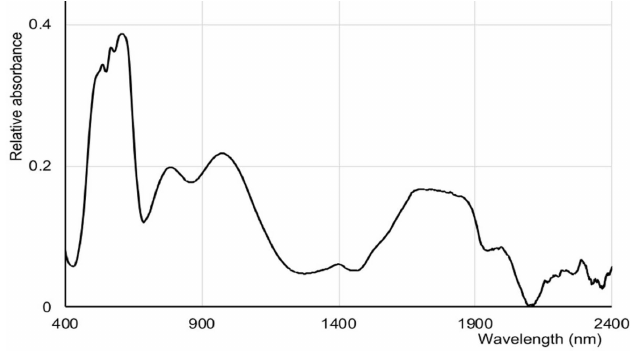
Figure 8 Solid-state Vis–NIR spectrum of [Co(Phpz)Cl 2 ].